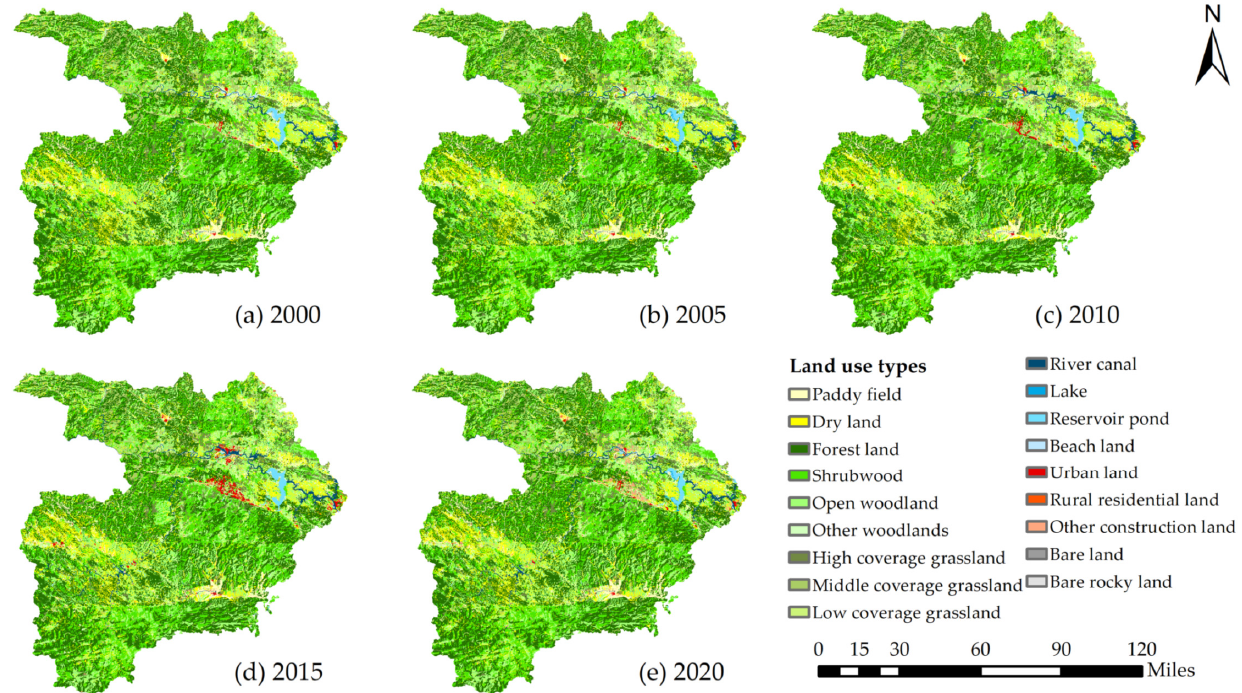
Figure 2. Land use types of Shiyan from 2000 to 2020: ( a ) 2000, ( b ) 2005, ( c ) 2010, ( d ) 2015, and ( e ) 2020.